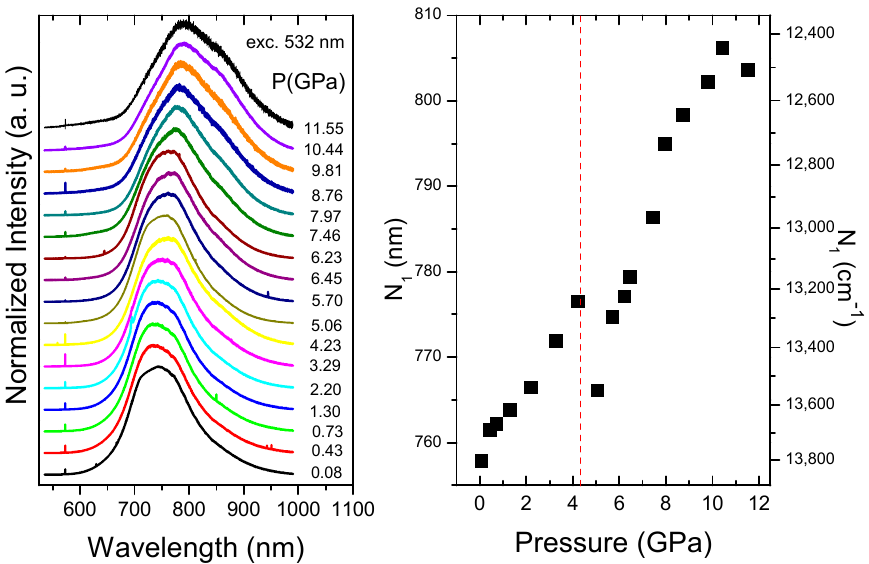
Figure 12. Pressure dependence of luminescence spectra of [(CuI) 2 (Quin)] compound obtained at ambient temperature under 532 nm laser excitation.